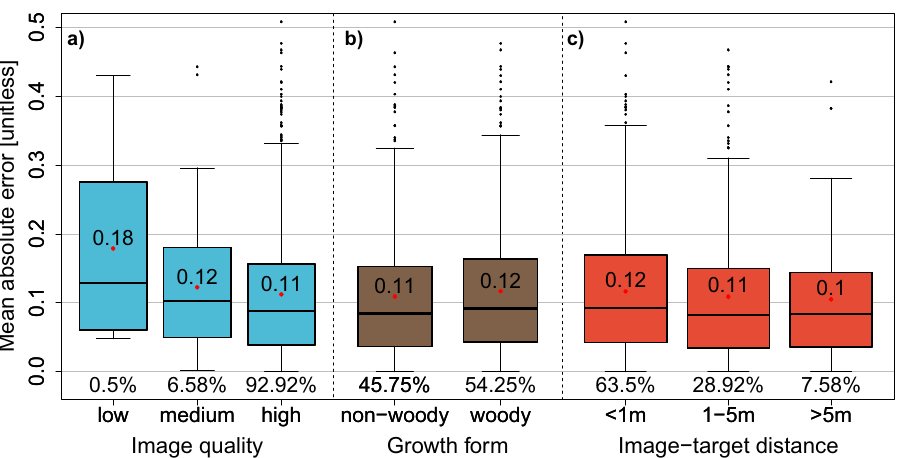
Figure 4. Model evaluation results. ( a-c ) Mean absolute errors across different image qualities ( a ), growth forms ( b ) and image-target distances ( c ) concerning 200 images per plant functional trait ( N = 1200 images). None of the images of the evaluation dataset were used in the training phase. The percentage of images falling in a category is indicated below each box plot. Red dots and the number linked to them are the mean absolute errors for each category. None of the groups differ significantly on p < .05 (Supplementary Table 4). 23